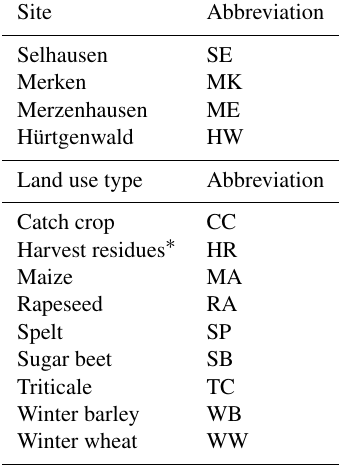
Table 2. Abbreviations for sites and land use types.